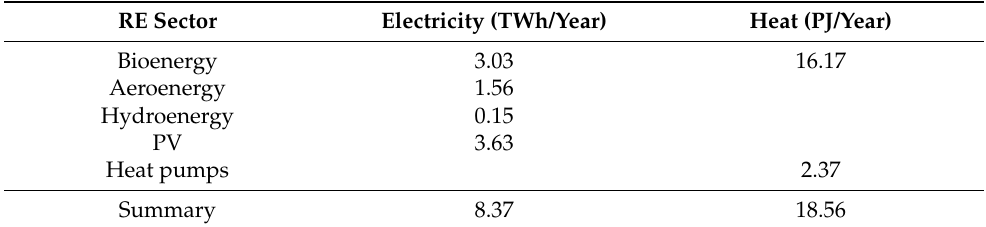
Table 6. Annual potential electricity and heat from renewable sources in the Pomerania Voivodeship (author’s own